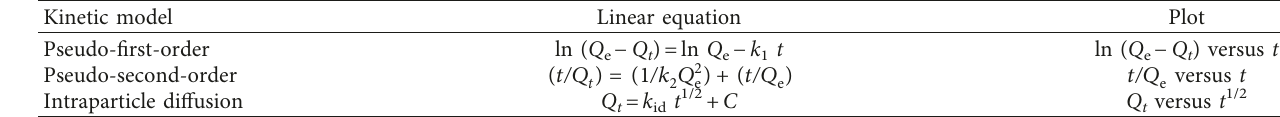
Table 1: Linearized equations for Ln 3+ sorption kinetics.